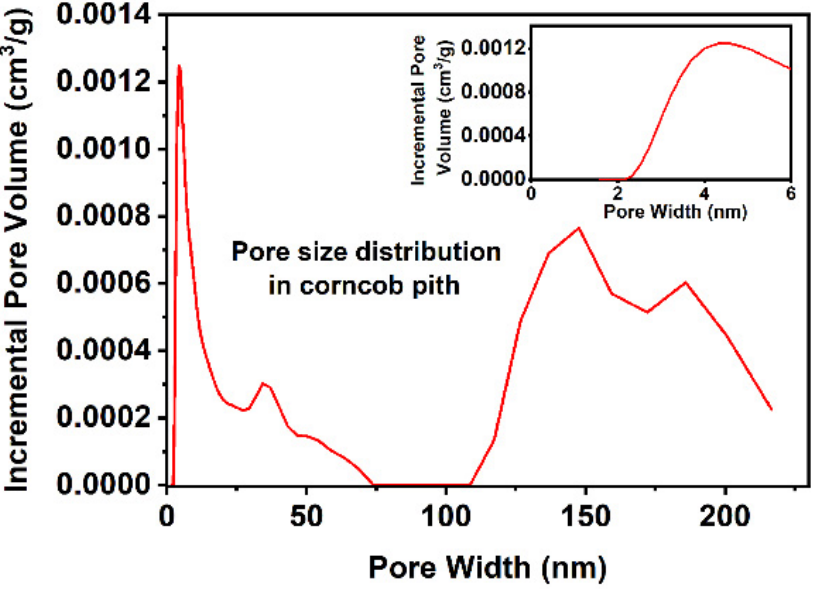
Figure 3. Pore size distribution in corncob pith (the illustration shows no pore size is less than 2 nm). Table 1. Summary of pore distribution of corncob